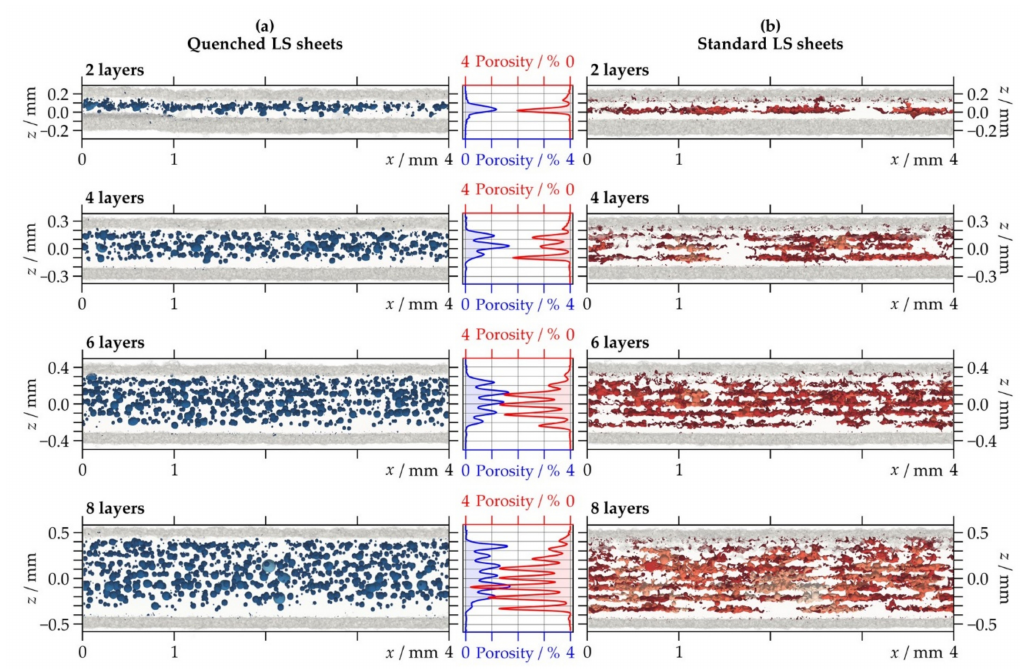
Figure 7. Semi-transparent view of visualized X-ray micro-computed tomography data through 4 mm (=1000 voxels) cross-sections and corresponding two-dimensional porosity distribution for ( a ) quenched and ( b ) standard laser-sintered (LS) polyamide 12 sheets generated with two, four, six, and eight